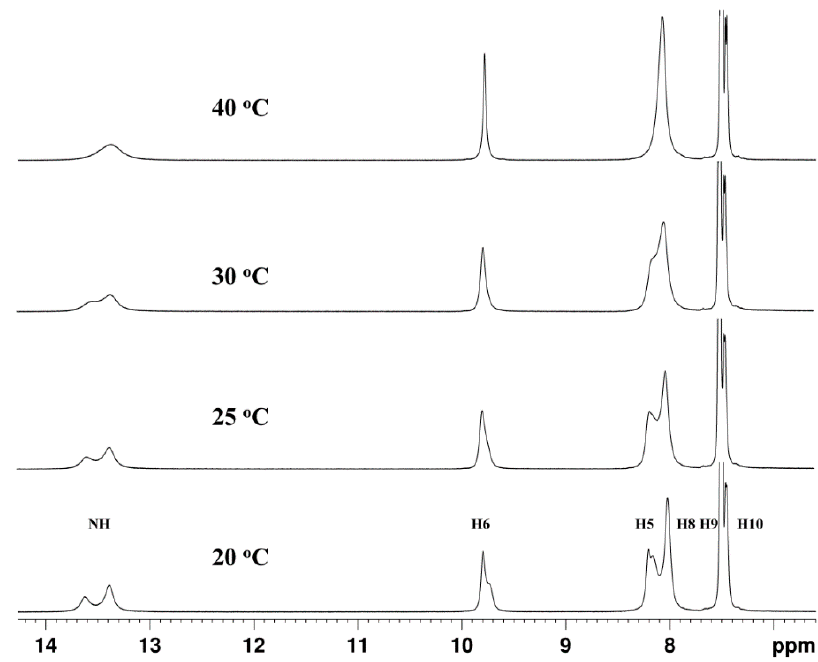
Figure 2. Temperature-dependent 1 H-NMR spectra (DMSO- d 6 ) of compound 2a .